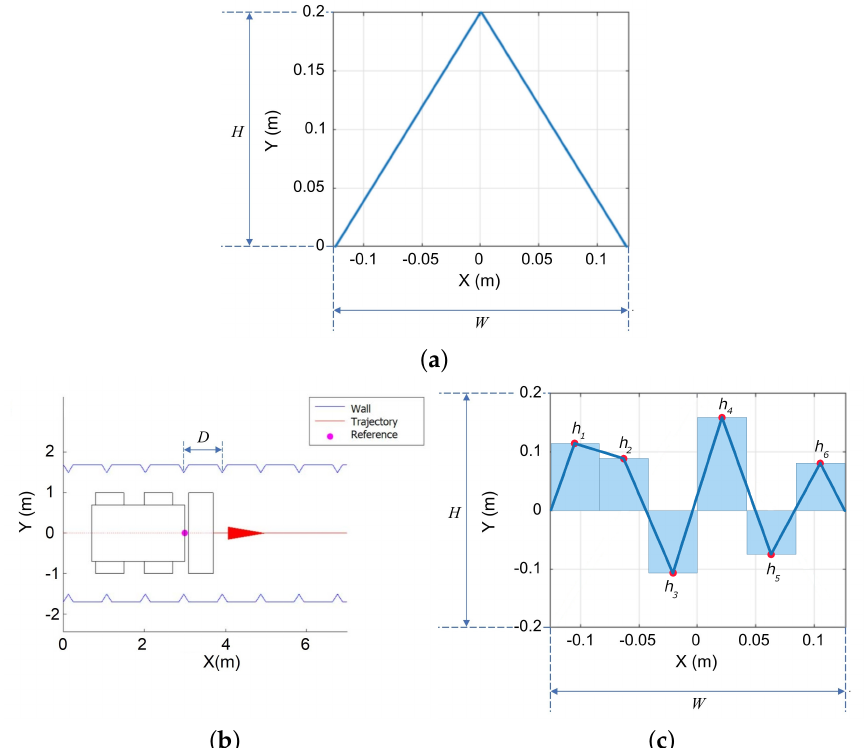
Figure 2. General size parameters of landmarks in terms of height H , width W in ( a ) and separation between landmarks D in ( b ). Shape parameters h i , i = 1,2, . . . ,6 of the piecewise linear free shape landmarks define segment height ( c